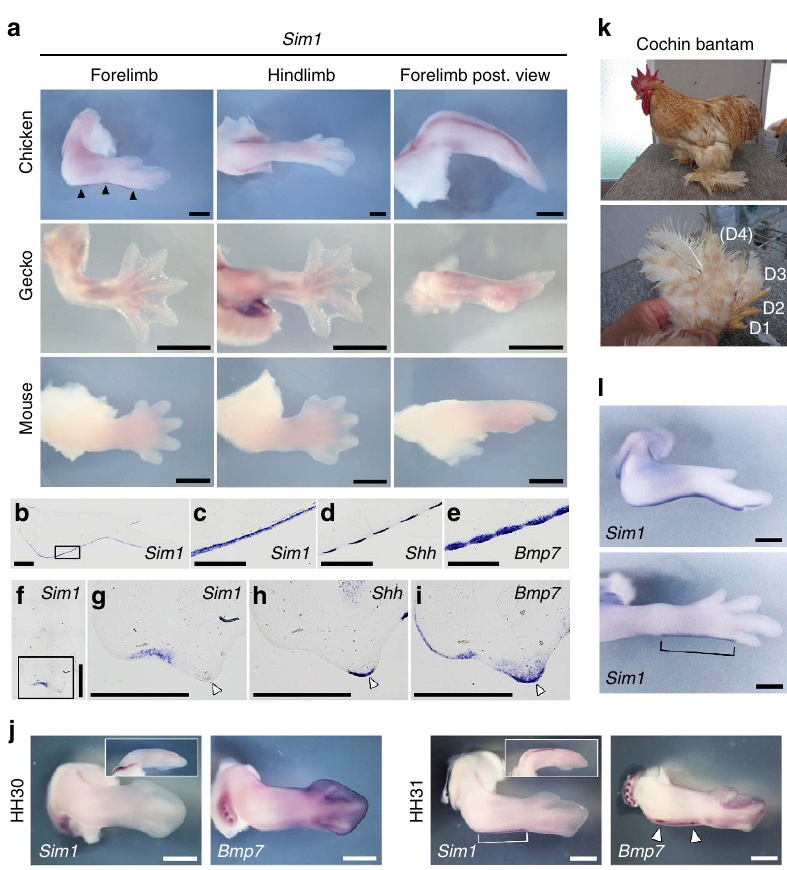
Figure 4 | Sim1 is specifically expressed in the avian forelimb and is associated with flight feather development. ( a ) Expression pattern of Sim1 in fore- and hindlimbs in chicken (HH32), gecko (23 dpo) and mouse (E13.5) embryos. Black arrowheads indicate specific expression in the posterior margin of the forelimb in chicken. ( b – e ) Expression of Sim1 ( b , c ), Shh ( d ) and Bmp7 ( e ) on the longitudinal sections of the chicken forelimb at HH35. ( c ) is a higher magnification image of boxed area in b . All photographs are oriented with distal to the right and posterior to the bottom. ( f – i ) Expression of Sim1 ( f , g ), Shh ( h ) and Bmp7 ( i ) on the transverse sections in the zeugopod region of the chicken forelimb at HH36. ( g ) is a higher magnification image of boxed area in f . White arrowheads indicate the flight feather buds. All photographs are oriented with dorsal to the right and posterior to the bottom. ( j ) Expression pattern of Sim1 and Bmp7 at HH30 and HH31. Neither the Sim1 expression nor the spot-like expression of Bmp7 was observed at HH30, whereas both of them were detected at HH31 (white bracket and arrowheads). Insets indicate the Sim1 expression from the posterior view. ( k ) Photos of the whole body (top) and the feathered foot (bottom) of an adult Cochin bantam. D1-4 incicate digits 1–4, respectively. Digit 4 is not seen from this angle because of heavily covering feathers. ( l ) Expression of Sim1 in the forelimb (top) and hindlimb (bottom) in the Cochin bantam embryo at HH34. Bracket indicates Sim1 expression in the hindlimb. Scale bars, 1mm ( a , b , j , l ); 500 m m ( c – i